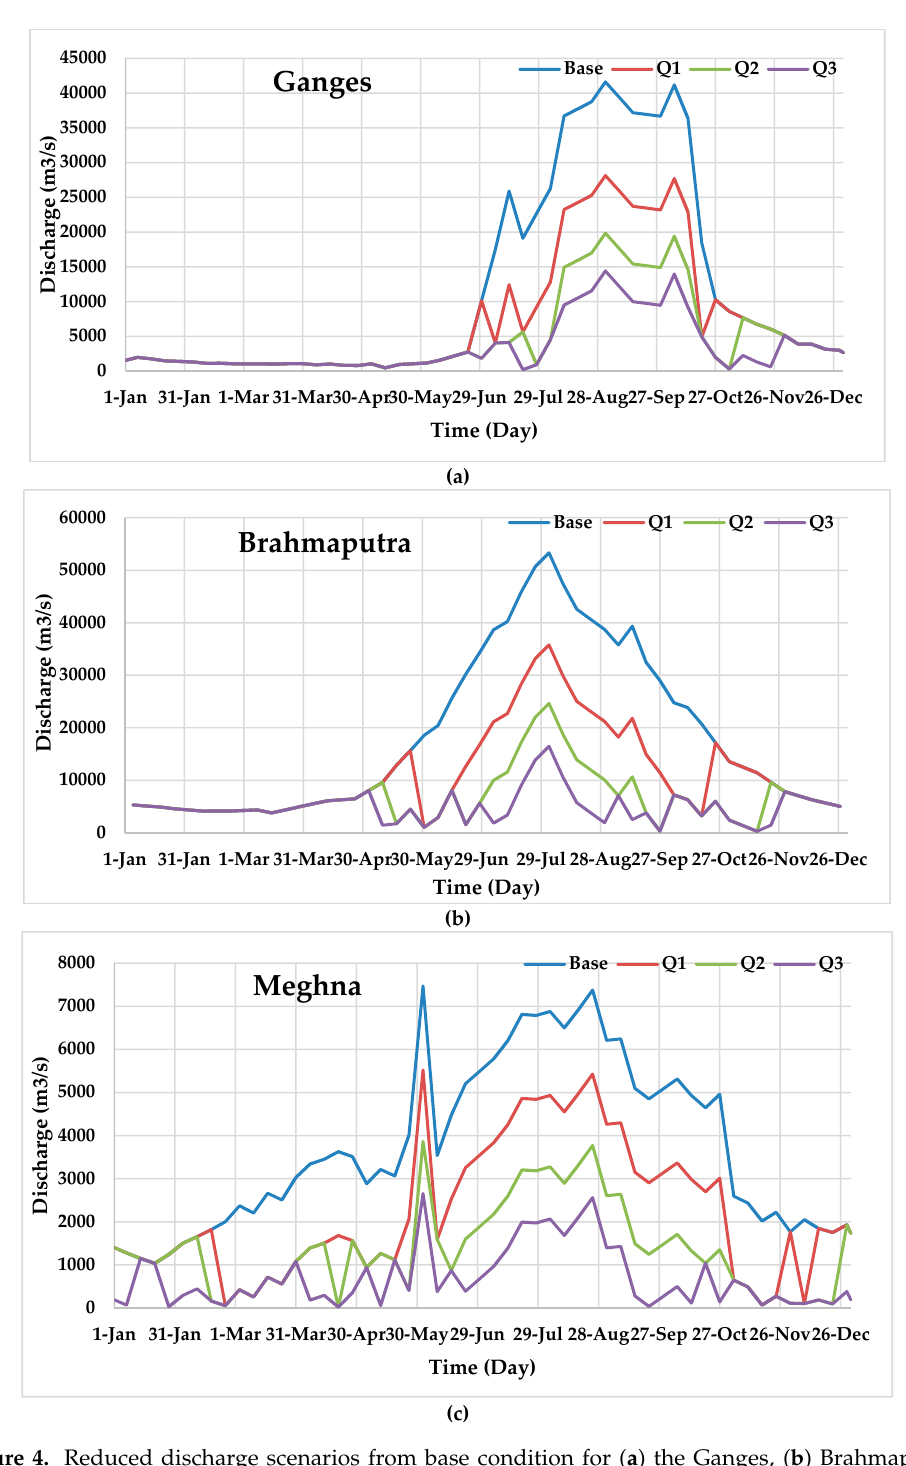
Figure 4. Reduced discharge scenarios from base condition for ( a ) the Ganges, ( b ) Brahmaputra, and ( c ) Meghna